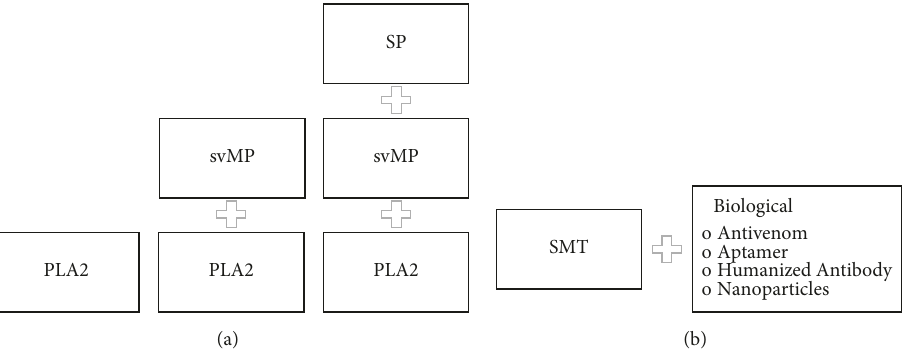
Figure 3: Hypothetical pipeline of SMTs for snakebite treatment. ( a ) Targeted inhibition of major snake venom enzymatic toxins, secreted phospholipase A2 (sPLA 2 ), and metallo- and serine-proteases (svMP and SP), through a combination of multiple inhibitory small molecules. ( b ) In combination with biologicals or others as adjuncts to antivenom for hospital administration (e.g., for targeting non-enzymatic toxins, such as